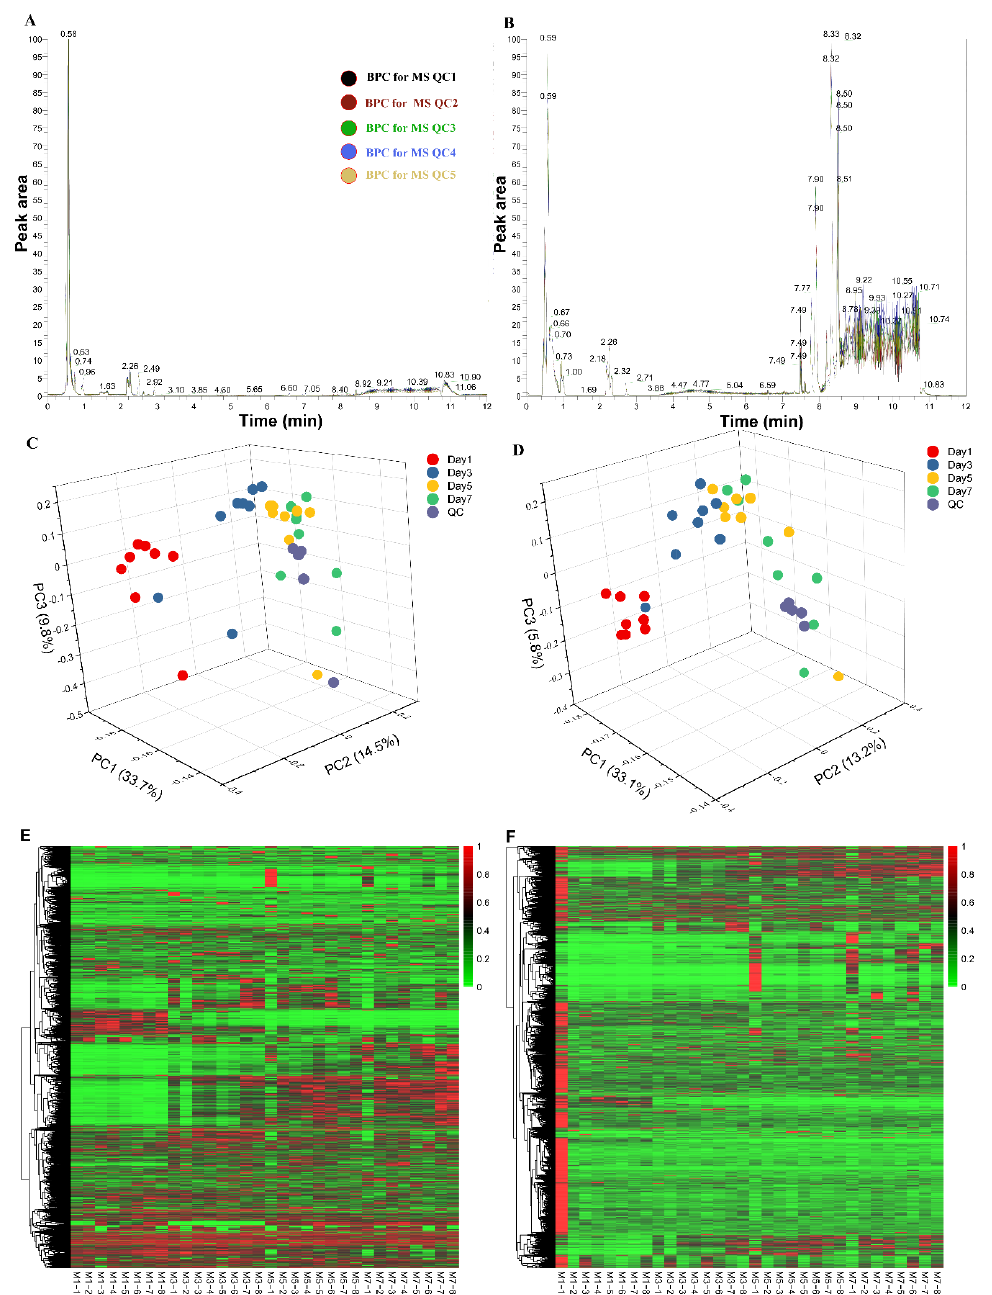
Figure 1. Quality control and metabolic profile analysis of chilled chicken samples. ( A ) Positive ion chromatograms of the five quality control samples; ( B ) negative ion chromatograms of the five quality control samples. Different colors represent samples; ( C ) principal component analysis (PCA) of all samples using positive ion mode data; ( D ) principal component analysis (PCA) of all the samples using negative ion mode data. PCA score plots displayed a low dispersion of quality control (QC) samples, which shows that there was minimal instrumental drift throughout the analysis; ( E ) heatmap clustering of all detected peaks using positive ion mode; ( F ) heatmap clustering of all the detected peaks using negative ion